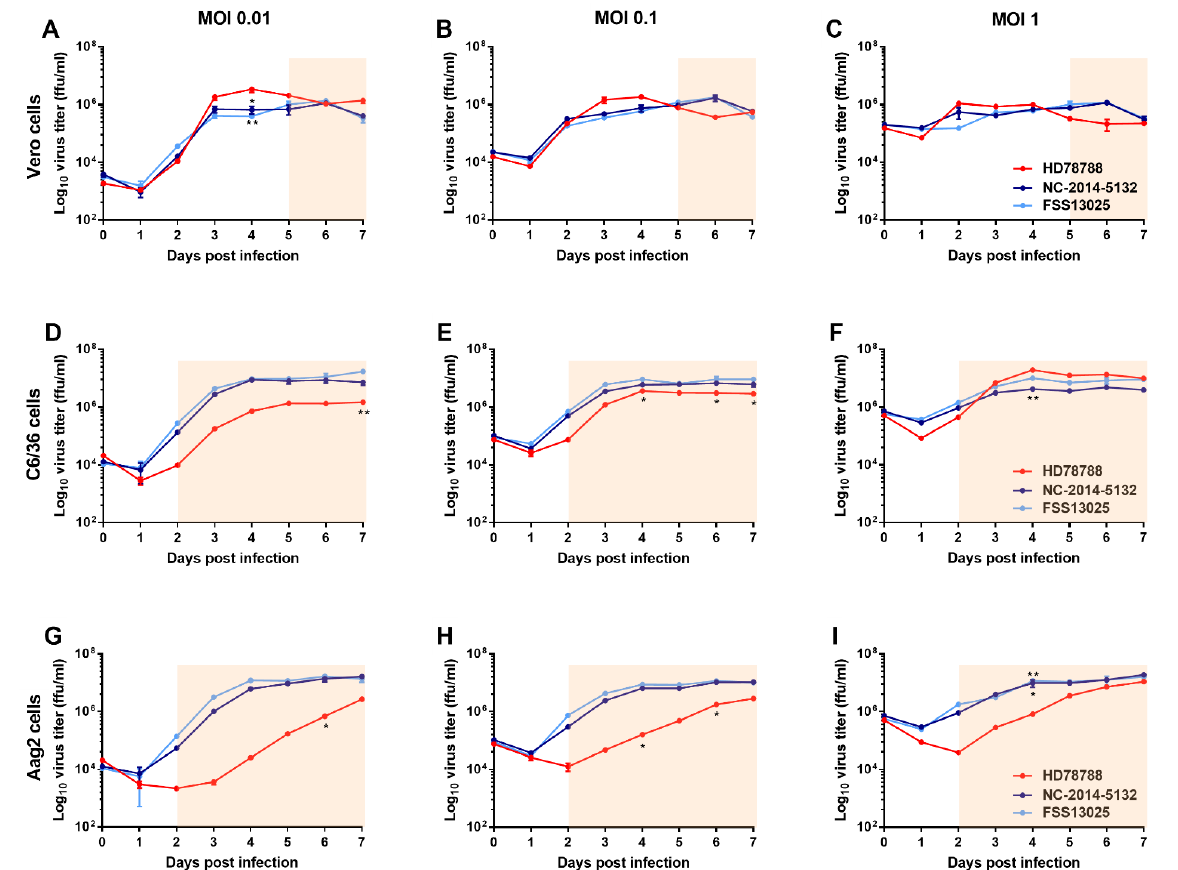
Figure 1. Zika virus (ZIKV) growth kinetic in different cell lines. ZIKV HD78788 (red), NC-2014-5132 (dark blue), and FSS13025 (light blue) were analyzed for their growth in vero ( A – C ) and mosquito cells (C6/36: ( D – F ); Aag2: ( G – I )). Cells were infected with different multiplicity of infection (MOI): 0.01 ( A , D , G ), 0.1 ( B , E , H ), and 1 ( C , F , I ). Values represent means ± standard deviation of duplicate experiments. Cytopathic effect was observed in cells infected with HD787888 (light red background squares). Statistical differences determined with two-way ANOVA analysis (Tukey’s multiple comparison correction) are marked by asterisks: * p < 0.05 and ** p < 0.01.